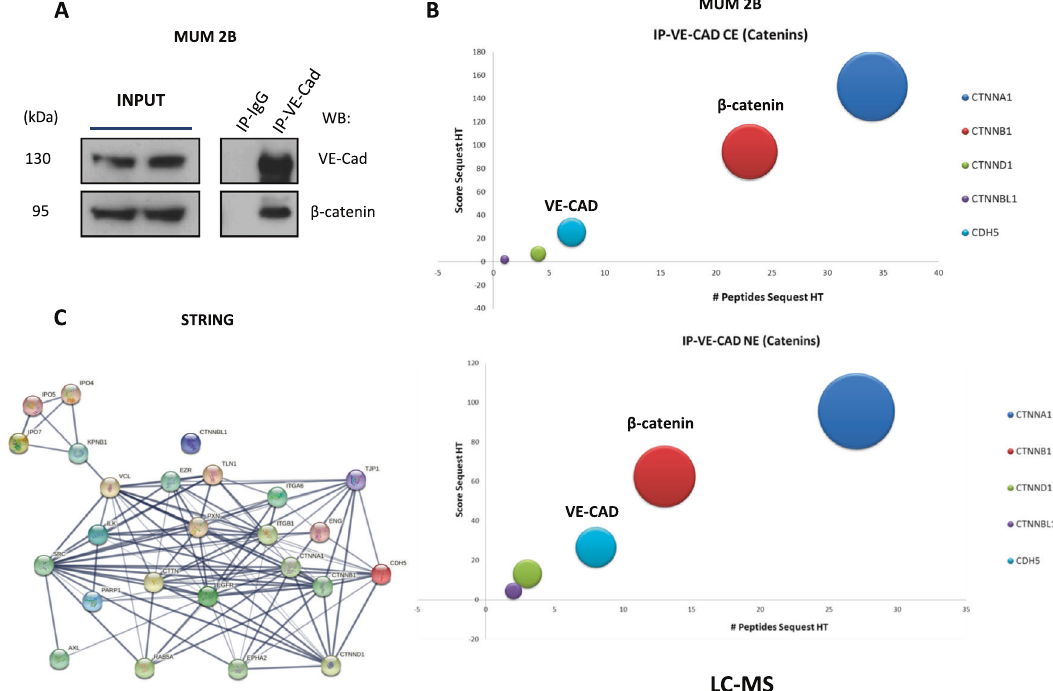
Fig. 1 LC-MS experiments showed an elevated coupling of β -catenin/VE-cadherin complex in VM. A Immunoprecipitation of VE-cadherin experiments shows union with β -catenin in MUM 2B cells, B representative union catenin to VE-cadherin graph of LC-MS proteomics IP-VE- cadherin CE (cytosol extract), NE (nuclear extract), score sequest HT in the X axis and #peptides sequest HT in Y axis. C String graph union protein of